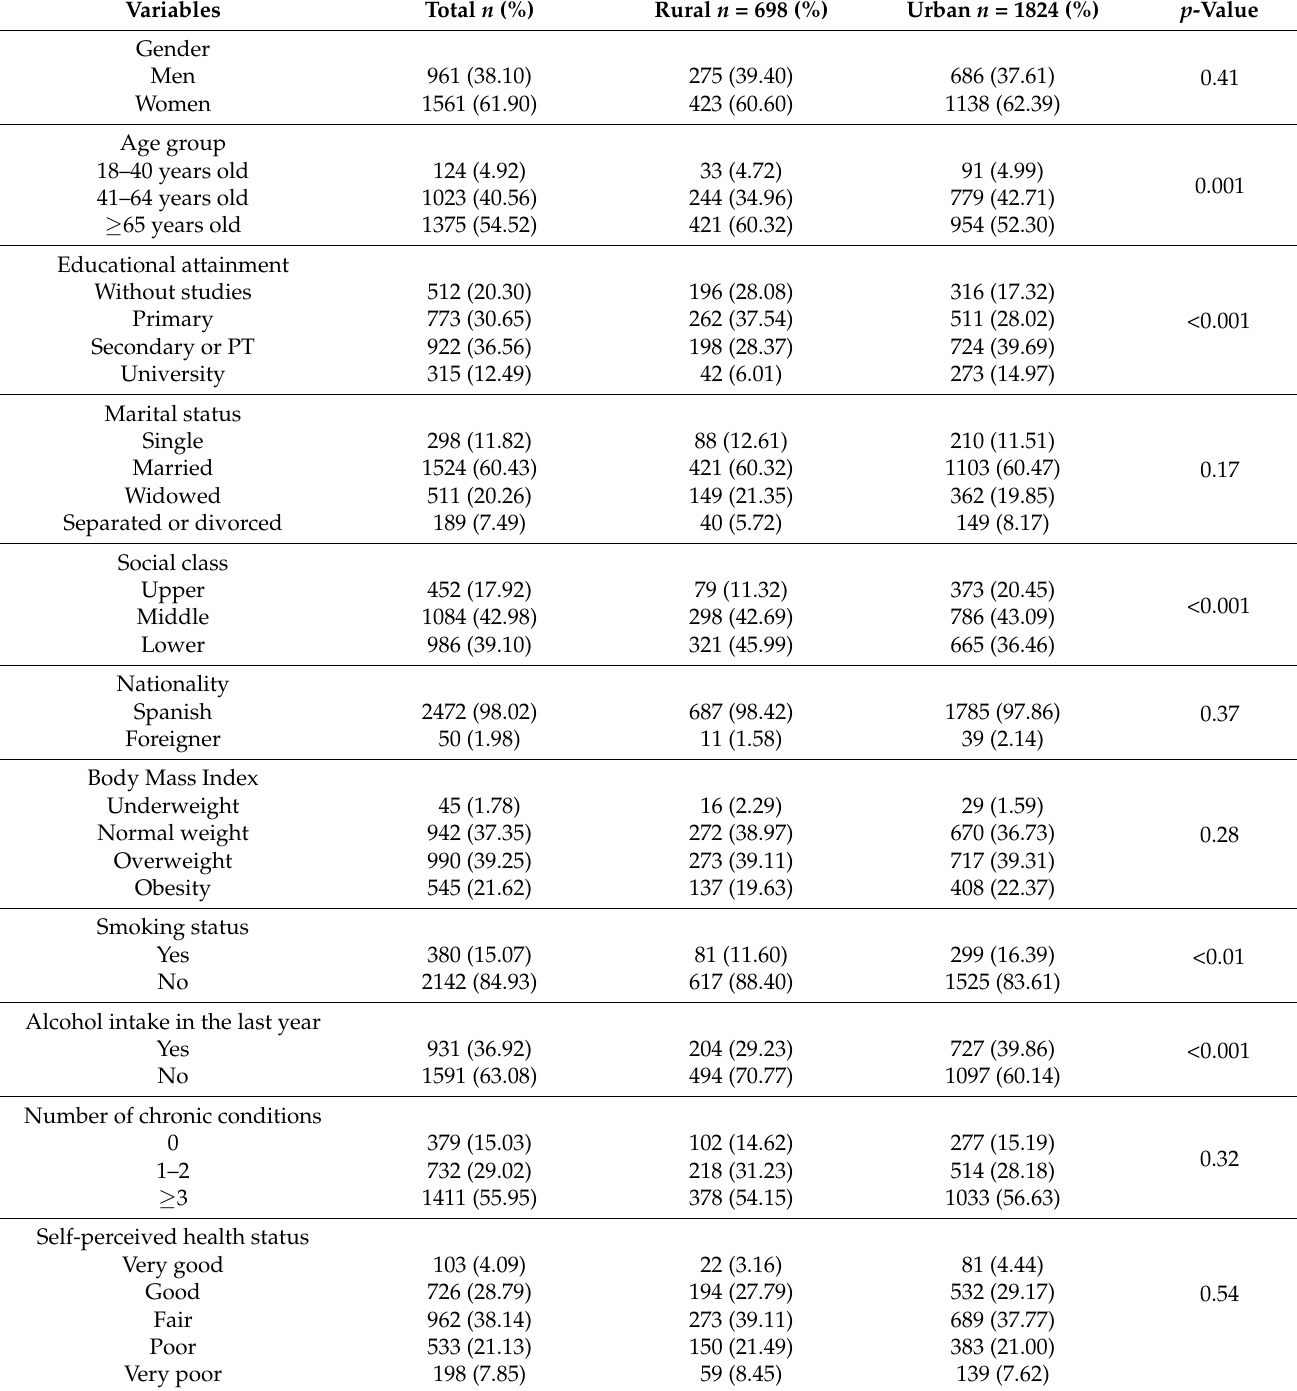
Table 1. Sociodemographic characteristics and health-related determinants of rural and urban cancer individuals ( n =